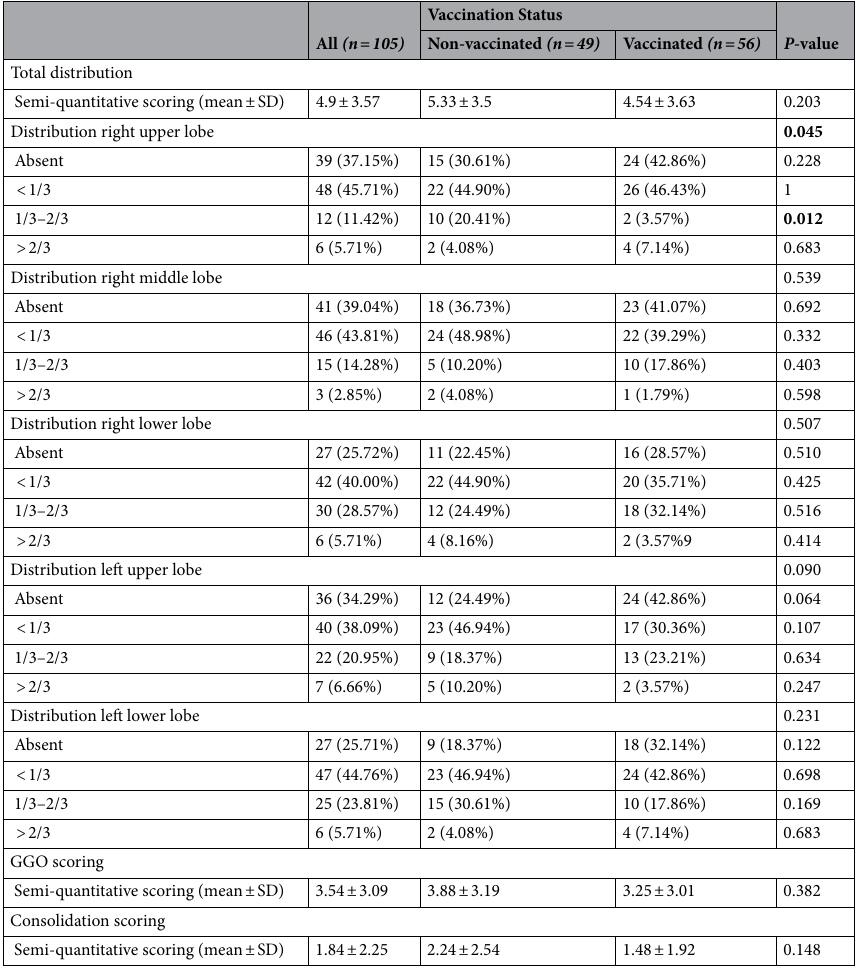
Table 4. Semi-quantitative scoring: CT-graphic pulmonary manifestation of COVID-19-infection according to vaccination status. For continuous variables, values are mean ± standard deviation (SD) with p ‐ values